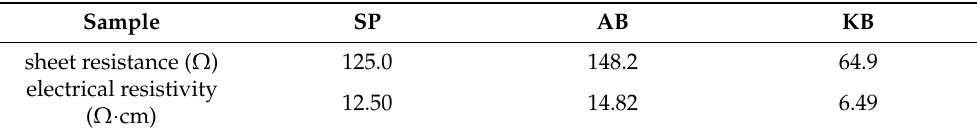
Table 1. The electrical resistance and electrical resistivity of anode electrodes.